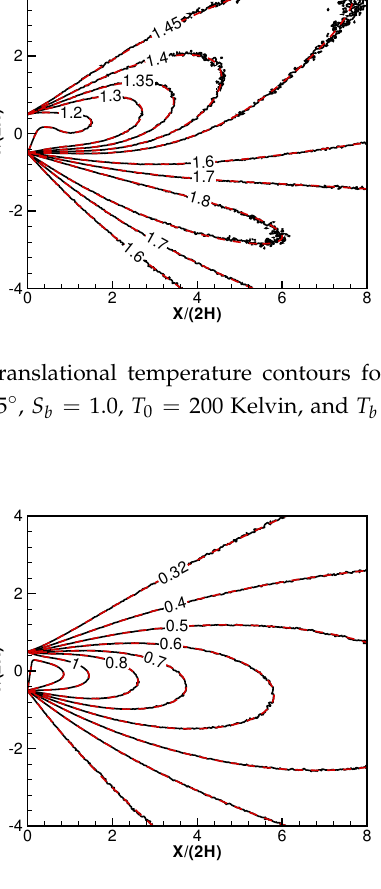
Figure 7. Nondimensional pressure contours for the jet/background mixture, n b / n 0 = 0.2, S 0 = 2.0, α 0 = 45 ◦ , S b = 1.0, T 0 = 200 Kelvin, and T b = 300 Kelvin. Red: analytical, black: